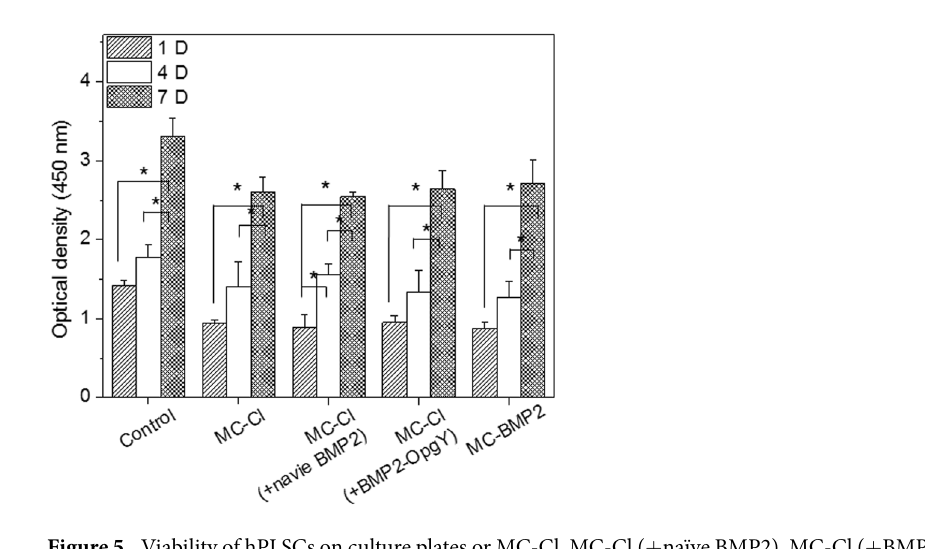
Figure 5. Viability of hPLSCs on culture plates or MC-Cl, MC-Cl ( + naïve BMP2), MC-Cl ( + BMP2-OpgY) and MC-BMP2 hydrogels measured with the WST-1 assay. Statistical analysis was per-formed using one-way ANOVA with Bonferroni’s multiple comparison correction ( * p <